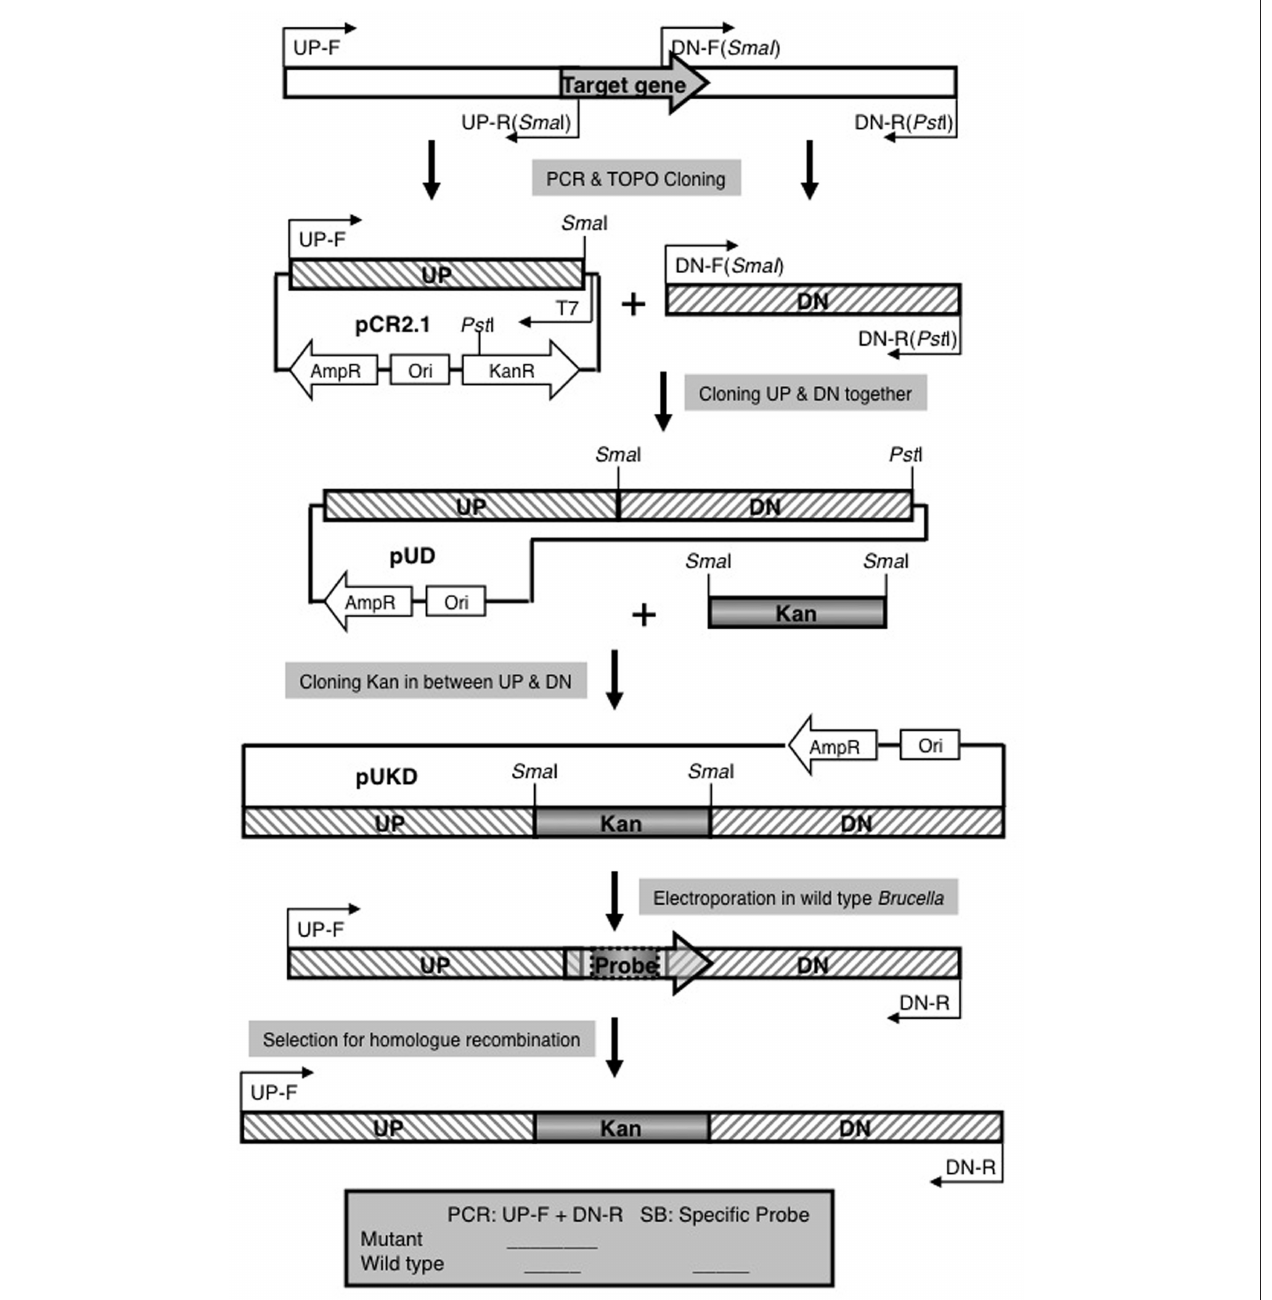
FIGURE A1 | Strategy for Allelic Exchange Mutagenesis. See Materials and Methods for